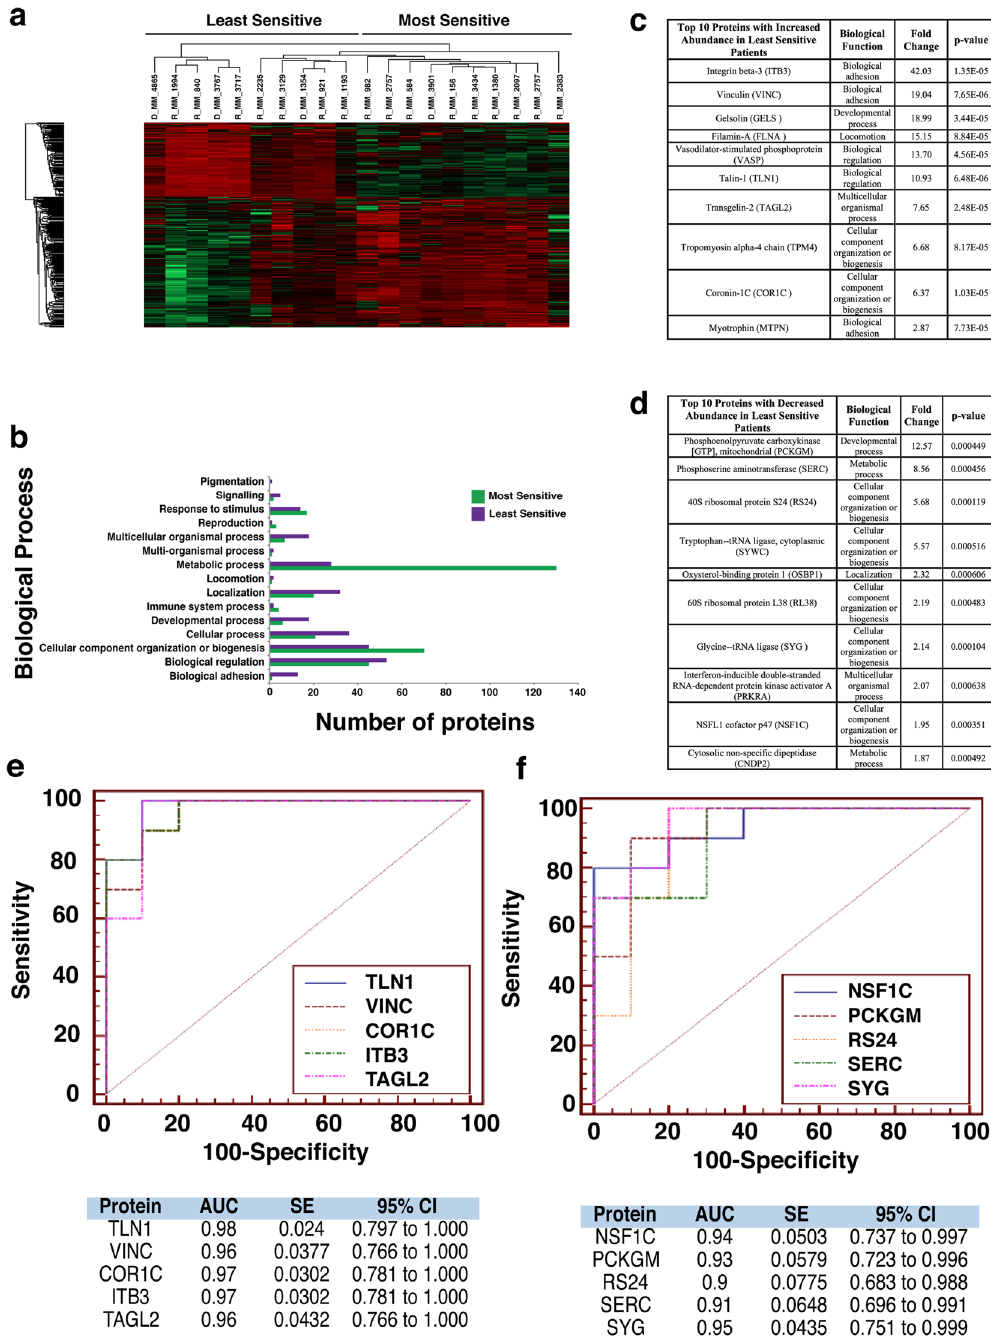
Figure 2. Proteomic analysis of patients following Bortezomib treatment. ( a ) Heatmap showing protein abundance changes of patients most and least sensitive to Bortezomib. Red indicates an increase in protein abundance, while green a decrease in protein abundance. ( b ) Graph showing the biological processes associated with the most and least sensitive patients. ( c ) List of the top ten proteins with increased abundance in the least sensitive patients. The associated biological function, fold change and p-value are also shown. Proteins were designated by p-value and arranged hierarchically by fold change. ( d ) List of the top ten proteins with decreased abundance in the least sensitive patients. The associated biological function, fold change and p-value are also shown. Proteins were designated by p-value and arranged hierarchically by fold change. ( e ) ROC analysis for the top five statistically significant proteins with an increased abundance for the least sensitive patients to bortezomib, including the calculated AUC, standard error (SE) and 95% confidence interval (CI). ( f ) ROC analysis for the top five statistically significant proteins with a decreased abundance for the least sensitive patients to bortezomib, including the calculated AUC, standard error (SE) and 95% confidence interval